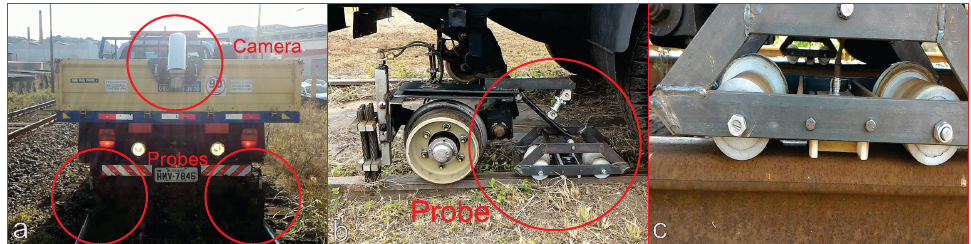
Figure 3. Probes installed in the inspection vehicle. ( a ) The camera and the two probes installed. ( b ) The probe attachment trolley. ( c ) A detailed view of the trolley.